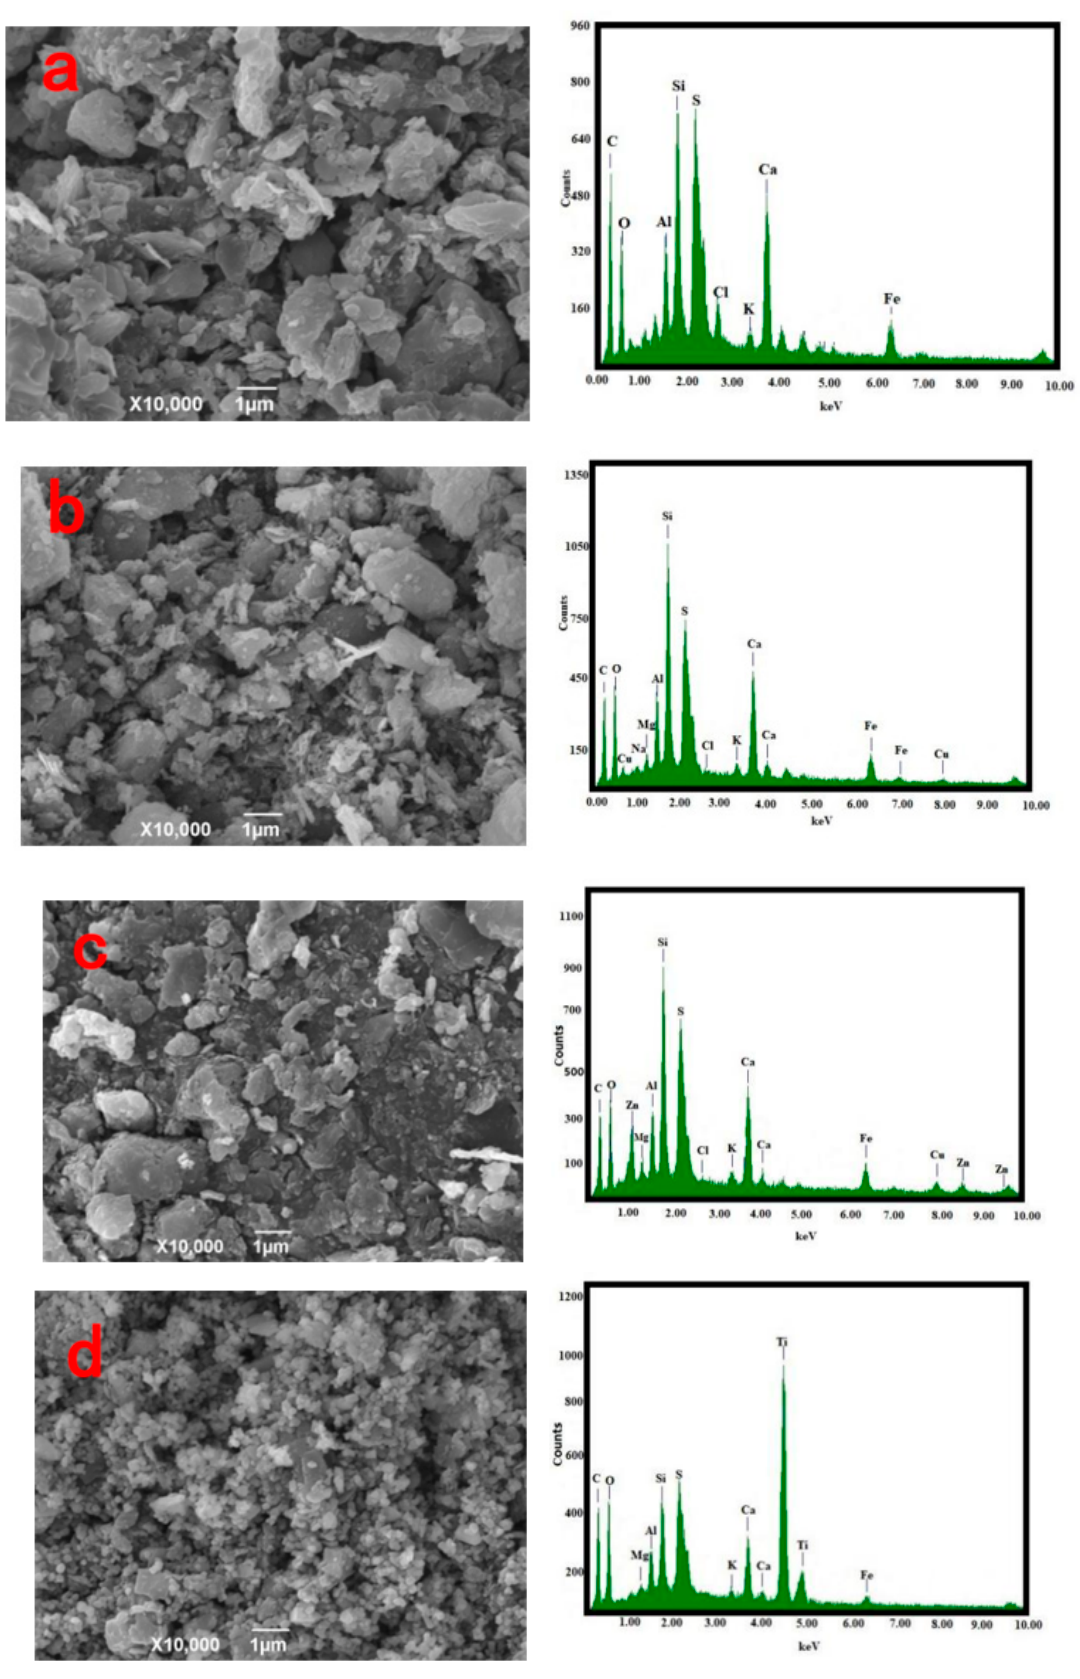
Figure 3. SEM and EDS images ( a ) oily sludge residue; ( b ) AC-CuO; ( c ) AC-ZnO; ( d ) AC-TiO 2 . BET Table 2 illustrates the specific surface area, pore volume, and pore size of AC-CuO, AC-ZnO, and AC-TiO 2 . The specific surface areas of AC-CuO, AC-ZnO, and AC-TiO 2 were 5.9082, 4.9138, and 7.8951 m 2 /g, respectively. It can be seen that the specific surface areas of AC-TiO 2 > AC-CuO > AC-ZnO were consistent with their respective removal effi- ciencies of methylene blue, which indicates that the pore structure of the composite mate- rial was involved in the removal of methylene blue. This conclusion is consistent with previous research findings [31,32]. In addition, by analyzing the ratio of mesopores to total pores, the mesoporosity of AC-CuO, AC-ZnO, and AC-TiO 2 was 93.69%, 94.44%, and 99.64%, respectively, indicating that the pore size distribution of AC-CuO, AC-ZnO, and AC-TiO 2 was dominated by the mesopores. Figure 4 shows the N 2 adsorption–desorption curves of AC-CuO, AC-ZnO, and AC- TiO 2 , respectively. All the curves did not overlap, which may be due to the small specific surface area of them and the underdeveloped pores. In addition, the N 2 adsorption–de- sorption curves were all closed, and the classification of the hysteresis loop belonged to the IV type, indicating AC-CuO, AC-ZnO, and AC-TiO 2 were mostly composed of meso- pores [33]. Figure 5 shows the pore size distribution curves of AC-CuO, AC-ZnO, and AC-TiO 2 , respectively. It can be seen that the pore size distributions were relatively concentrated, and the pore structure was dominated by mesopores between 2 and 20 nm, with almost no macropores. This result is consistent with that of N 2 adsorption–desorption analysis. The concentrated pore size distribution facilitated the methylene blue removal process [34]. Table 2. Specific surface area and pore volume of the composite materials. Source